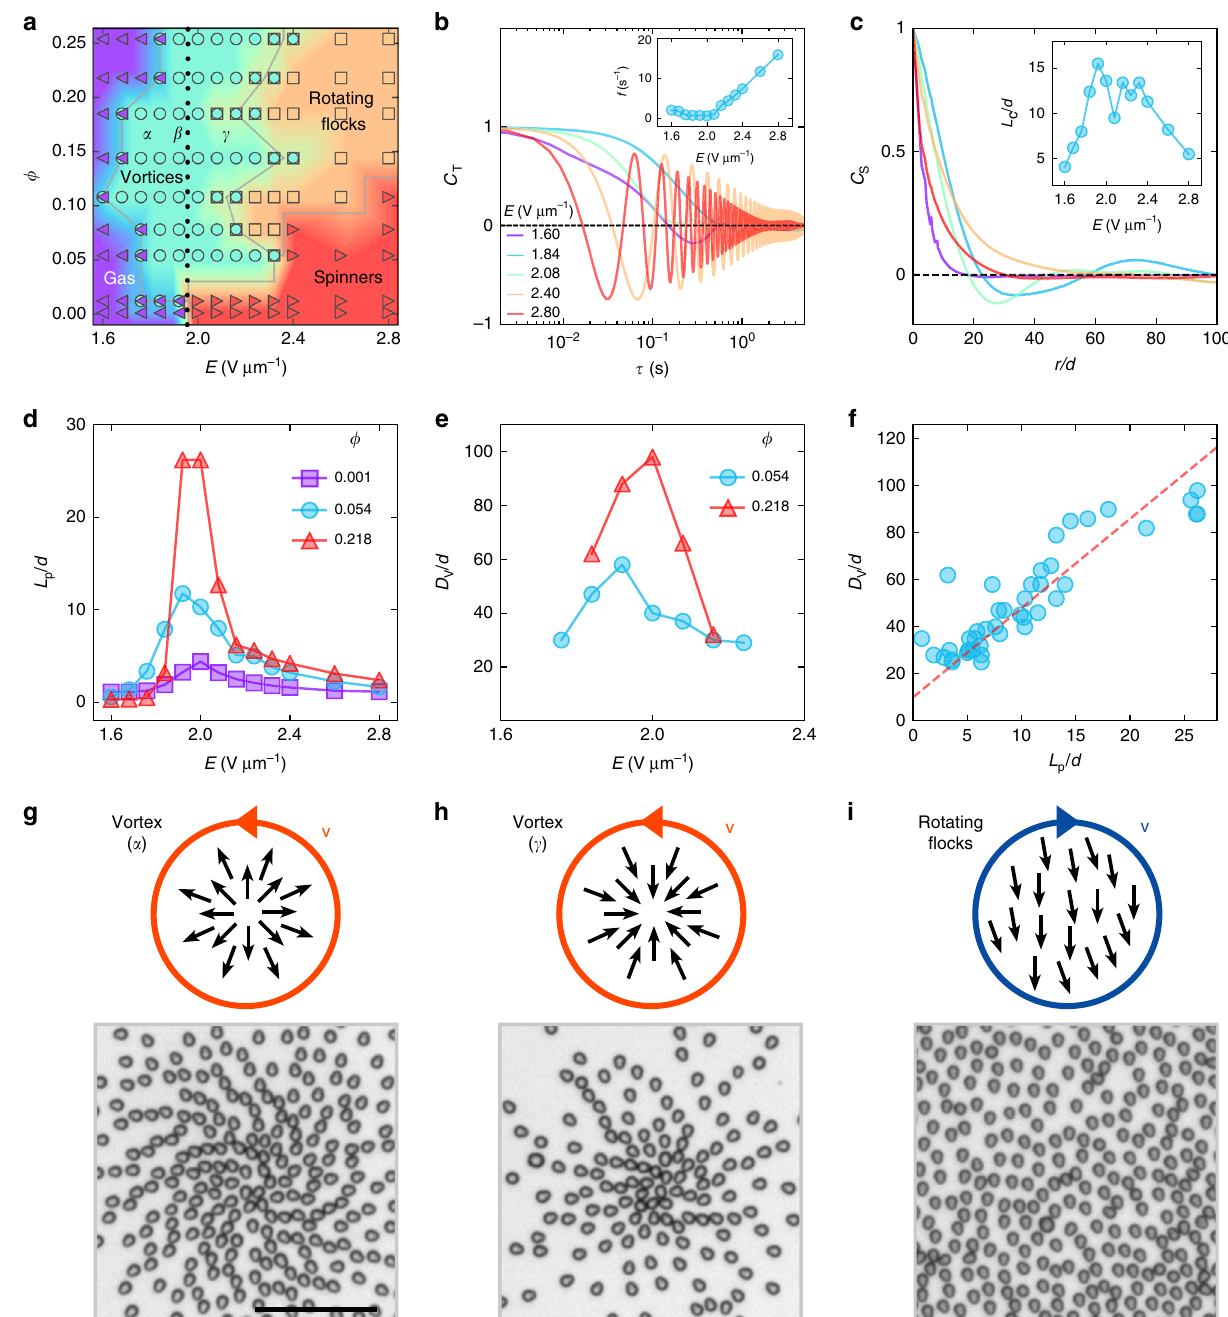
Fig. 3 Emergent patterns in chiral rollers swarms. a Phase diagram of the dynamic states in a chiral roller ensemble. Gas, vortices, rotating fl ocks and spinners phases are shown as left triangles, circles, squares and right triangles, respectively. Different phases are discriminated with the help of the temporal correlations of the corresponding velocity fi elds, see ‘ Methods ’ . The black dotted line indicates the transition from α to γ rolling. b Time evolution of the velocity temporal correlation function C T of rollers shown for different magnitudes of the electric fi eld. Insert: frequency of the rotations as a function of the electric fi eld obtained by the fast Fourier transform (FFT) of C T . ϕ = 0.108. c Velocity spatial correlation function C s of the rollers at different activity levels. d is the particle size. The color scheme is the same as in ( b ). Inset: the correlation lengths L c versus electric fi eld. The presence of a valley of suppressed L c values with a local minimum at E = 2.08 V μ m − 1 corresponds to the region of vortices with strong negative correlation in C s . ϕ = 0.108. d Persistence length, L p , as a function of fi eld strength at different area fractions ϕ . e Vortex size, D v , as a function of the fi eld strength. f Characteristic vortex size, D v as a function of the persistence length, L p . The dash line is a linear fi t. g – i Local ordering of rollers in self-organized emergent patterns. g a ‘ heads-out, ’ α -vortex, with all the rollers oriented away from the vortex center. E = 1.84 V μ m − 1 and ϕ = 0.108. h a ‘ heads-in, ’ γ -vortex, formed by rollers oriented toward the vortex eye. E = 2.08 V μ m − 1 and ϕ = 0.108. i a rotating fl ock. The same rotating fl ock is indicated by a black square in Fig. 2d, e. E = 2.60 V μ m − 1 and ϕ = 0.254. All rollers within the fl ock synchronously point in one direction while the direction of the fl ock itself rotates. Scale bar is 0.1 mm. See also Supplementary Movies 2, 5, and 7 –